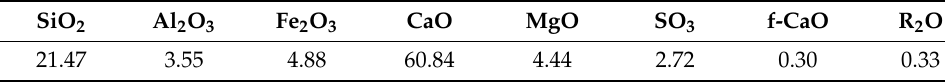
Table 2. Mix proportion of concrete (kg/m 3 ).